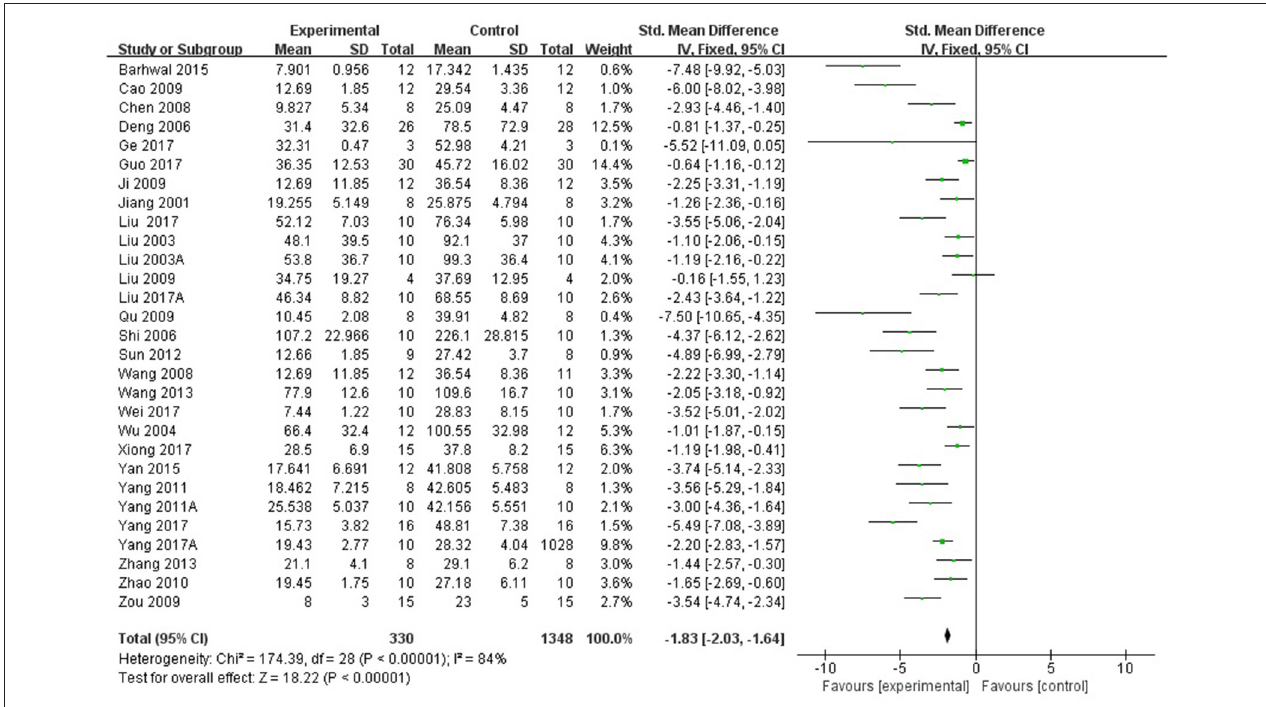
FIGURE 2 | The forest plot: effects of Rhodiola rosea L. for decreasing the escape latency in MWM compared with control